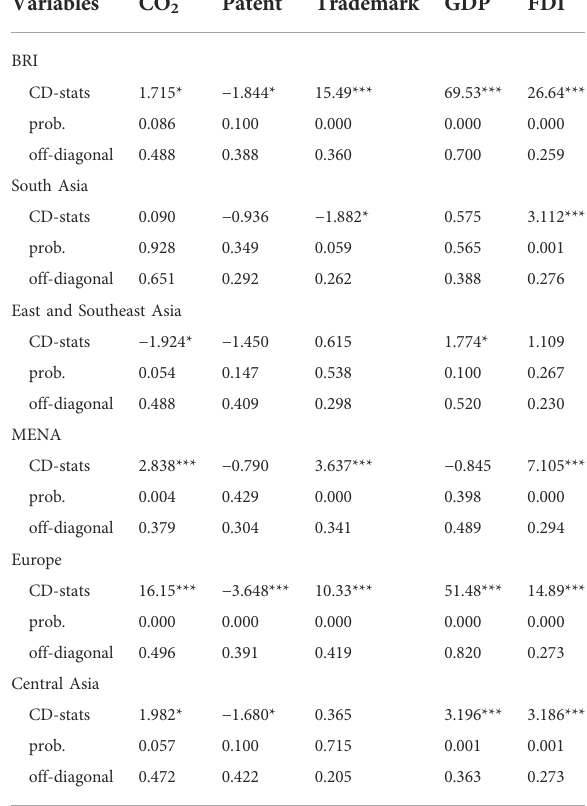
TABLE 4 CD test